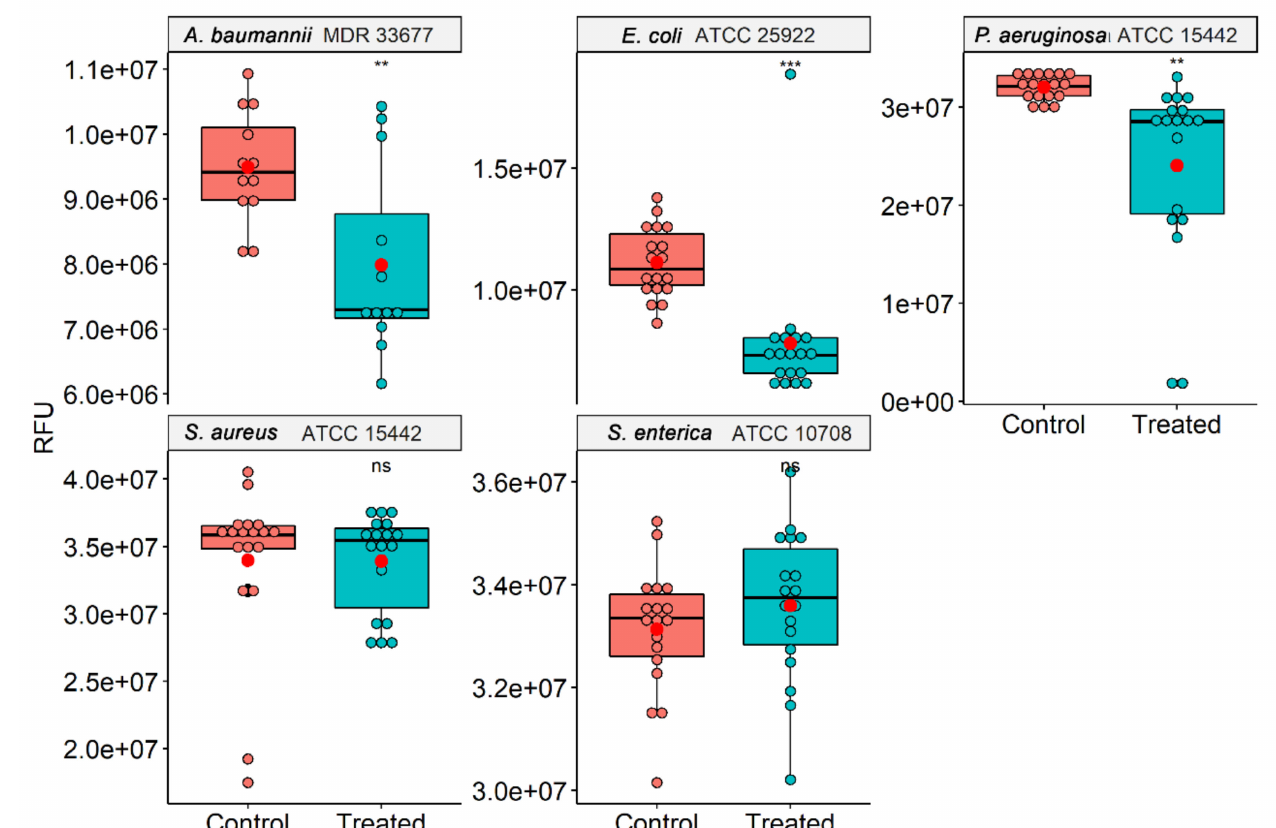
Figure 2. Viability of different bacteria ( A. baumannii , E. coli , P. aeruginosa, S. aureus , and S. enterica ) after exposure to ozone for 10 h using resazurin as a metabolic indicator. Viable bacteria convert resazurin into fluorescent resorufin, comparison of O 3 exposure of different colonies was visualized in a boxplot. Red dots represent the mean of the relative fluorescence from each group. Statistically significant using t -test (** p < 0.01; *** p <